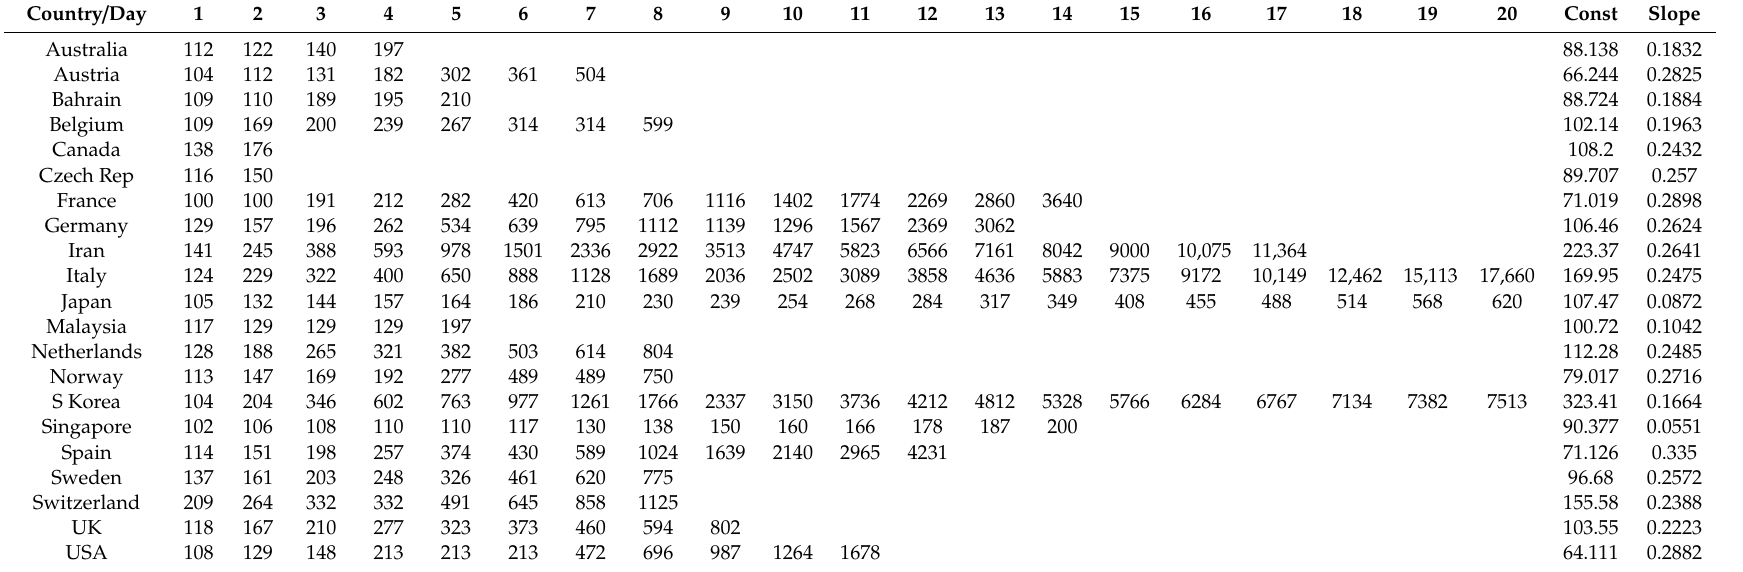
Table 3. Slope of exponential model fitted to data in Table 2 as a function of mean annual temperature in that country. The Pearson correlation coe ffi cient is R = − 0.568, one-tailed p =